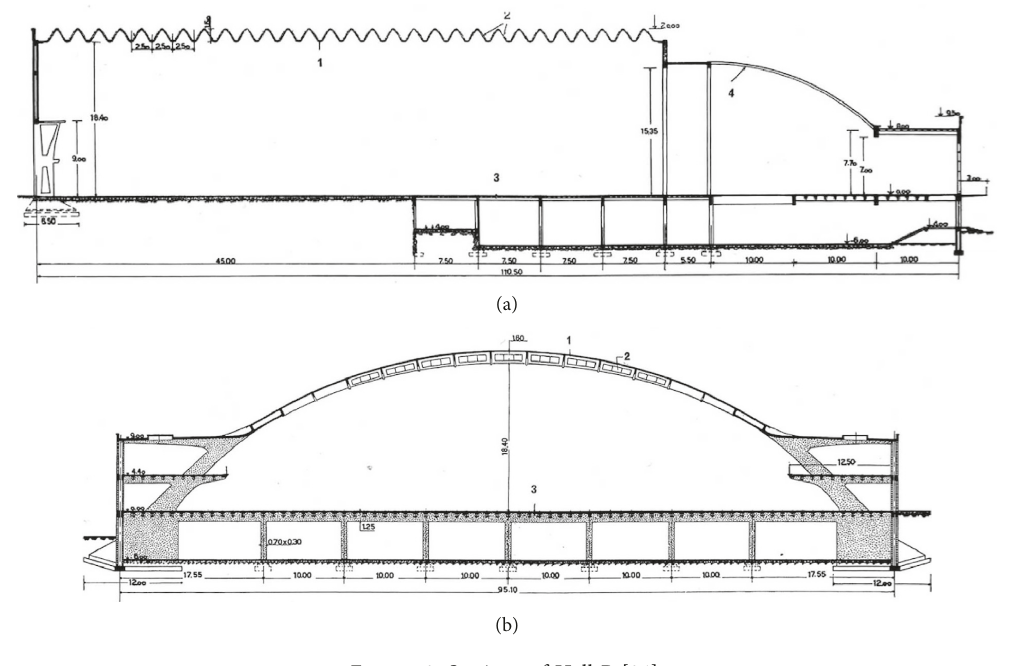
Figure 3: Sections of Hall B